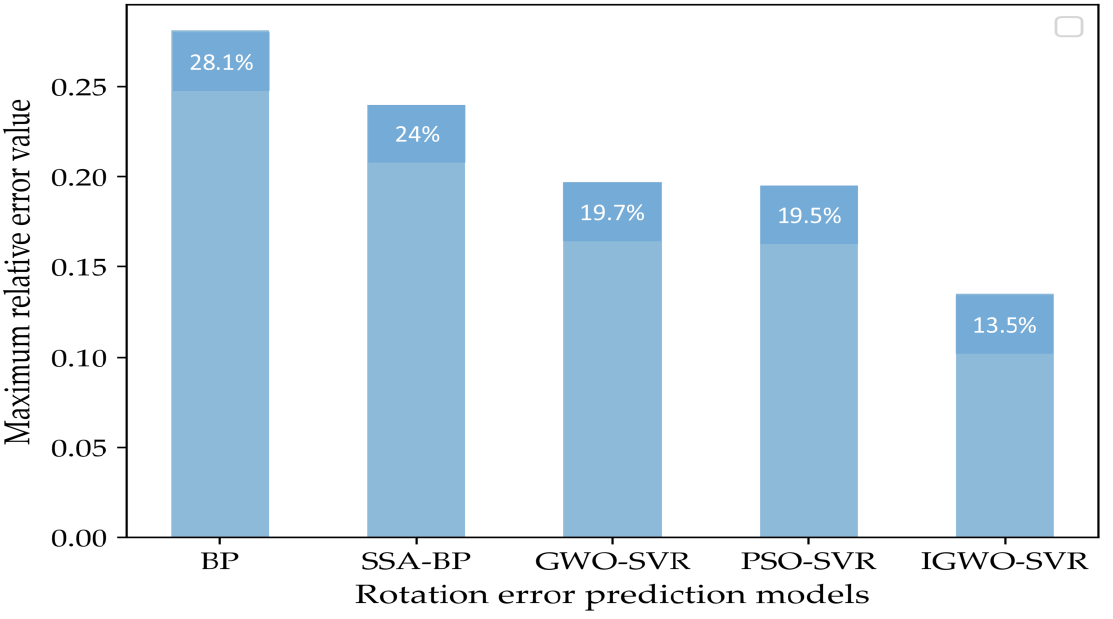
Figure 13. Maximum relative error of different prediction methods.